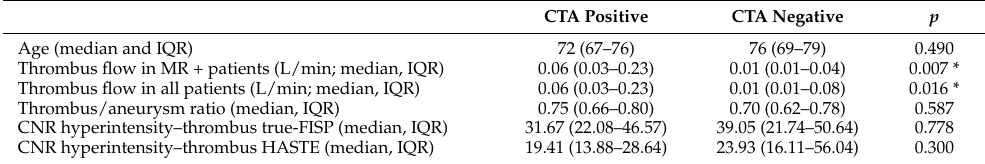
Table 4. Comparison of MRI characteristics between patients with a positive and negative